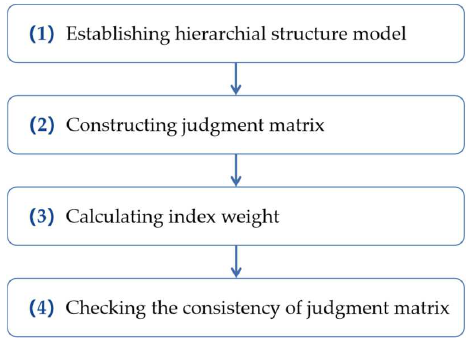
Figure 2. The analytical steps of the